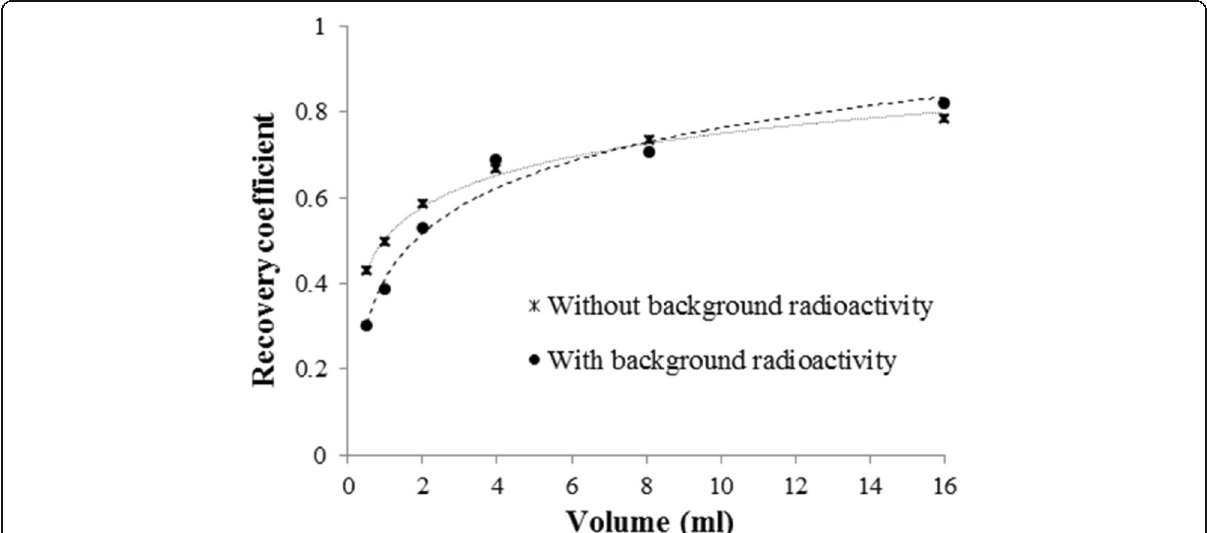
Fig. 2 Recovery coefficients in function of the volume using six iterations and ten subsets with a Gaussian post-filter of 0.11 cm, and attenuation, scatter and recovery resolution correction. For the objects ranging from 0.5 to 16 ml, the recovery coefficients ranged from 0.43 to 0.78 when using the phantom without background radioactivity (dash-dot line) and from 0.30 to 0.82 with the phantom with background radioactivity (dotted